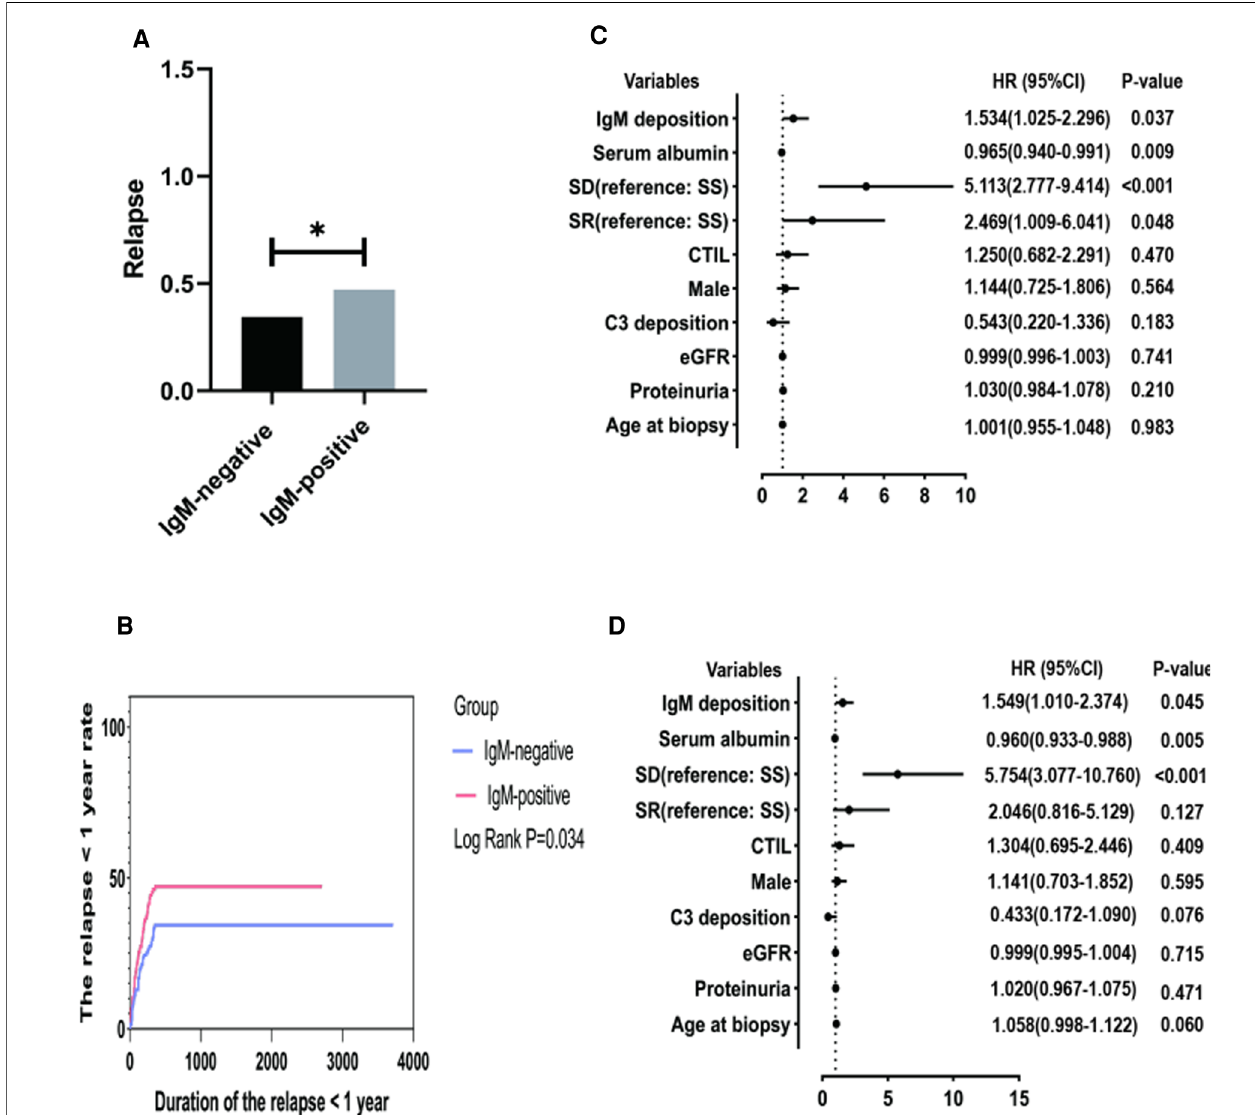
FIGURE 3 The minimum follow-up was 1 year. SD, steroid-dependent; SR, steroid-resistant; SS, steroid-sensitive; eGFR, estimated glomerular fi ltration rate; CTI, chronic tubulointerstitial injury; ( A ) Comparison of relapses between the two groups. ( B ) Cumulative rate of the fi rst remission. ( C ) Independent predictors of the fi rst relapse by univariate cox regression analysis. ( D ) Independent predictors of the fi rst relapse by multivariate cox regression